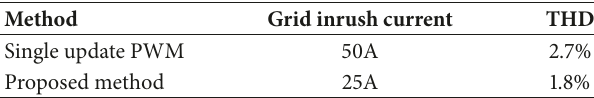
Table 4: The dynamic simulation results of grid currents.